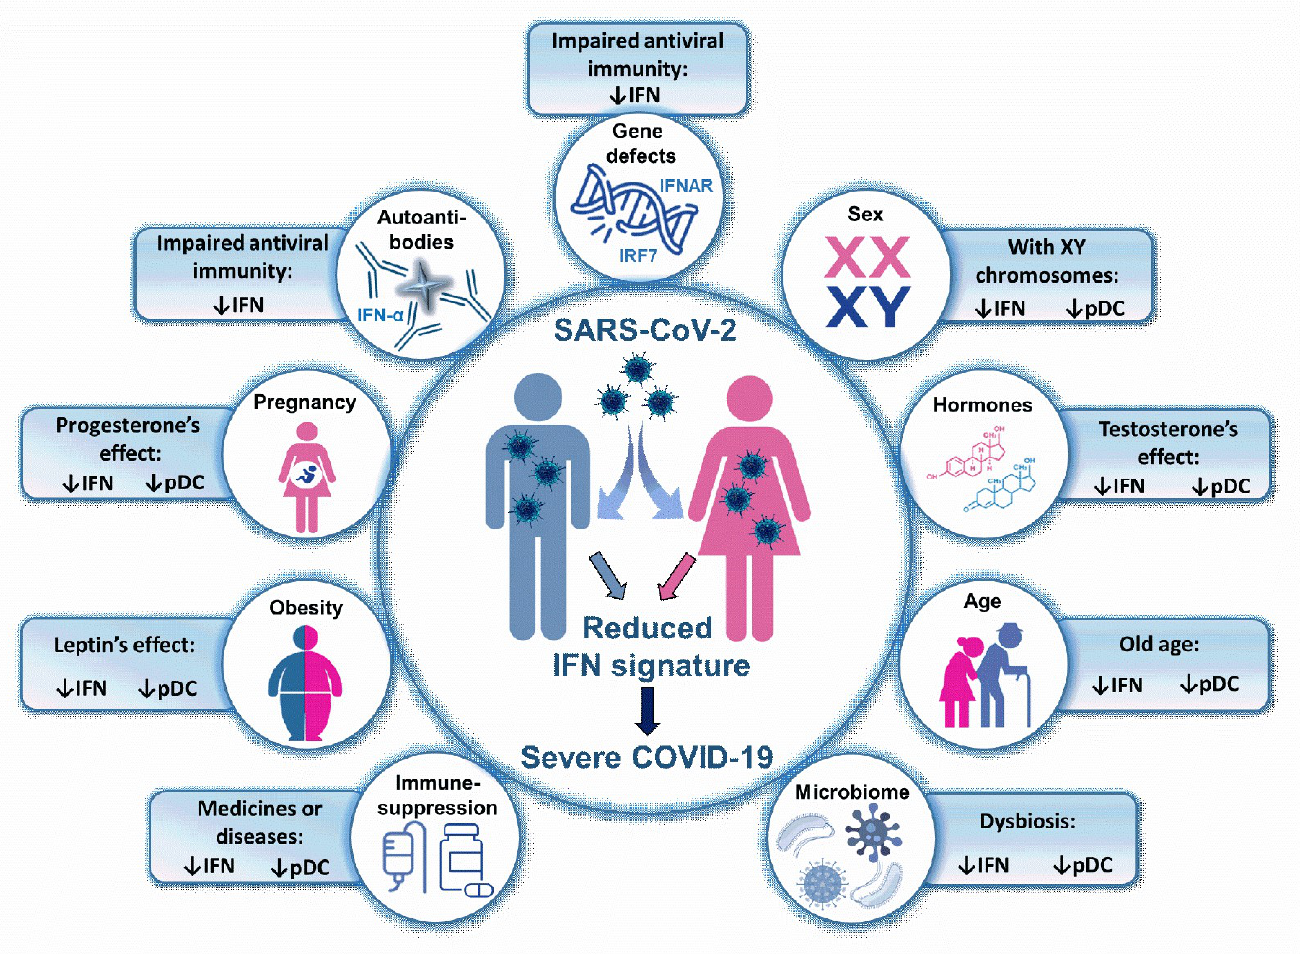
Figure 3. Type I IFN related risk factors in COVID-19. A low IFN signature predicts a more severe COVID-19 outcome. Thus, those conditions, which are associated with impaired type I IFN response or decreased pDC number may be risk factors for severe COVID-19. IFN: interferon; pDC: plasmacytoid dendritic cell, IRF: interferon regulatory factor; IFNAR: interferon- α / β receptor